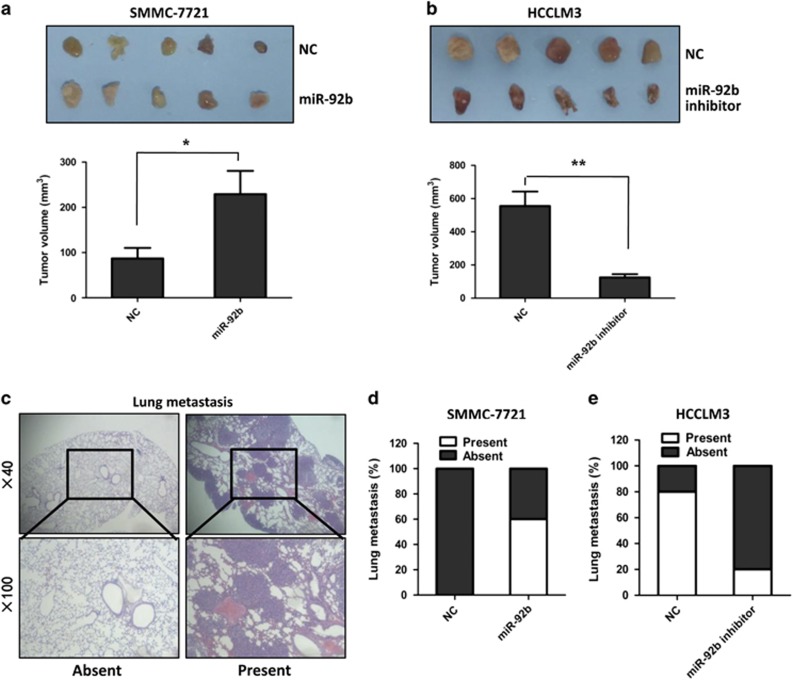
Effects of miR-92b on HCC cell proliferation and metastasis in vivo. (a and b) The HCC mouse model was constructed by using SMMC-7721 cells infected with miR-92b lentivirus and HCCLM3 cells infected with lentivirus-based miR-92b inhibitor. The size of local liver tumors in these two groups was calculated and compared in the diagrams. Results were represented as mean±S.D. (n=5). *P<0.05; **P<0.01. (c) Typical pictures for lung metastasis of HCC mouse model. Images were captured at × 40 (up) and × 100 (down). (d and e) The percentage of mice with or without metastatic nodules in the lungs was calculated